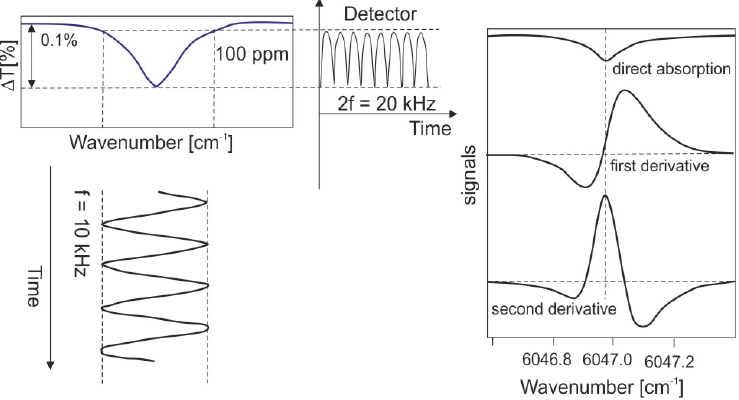
Figure 11. The phase-sensitive detection method.